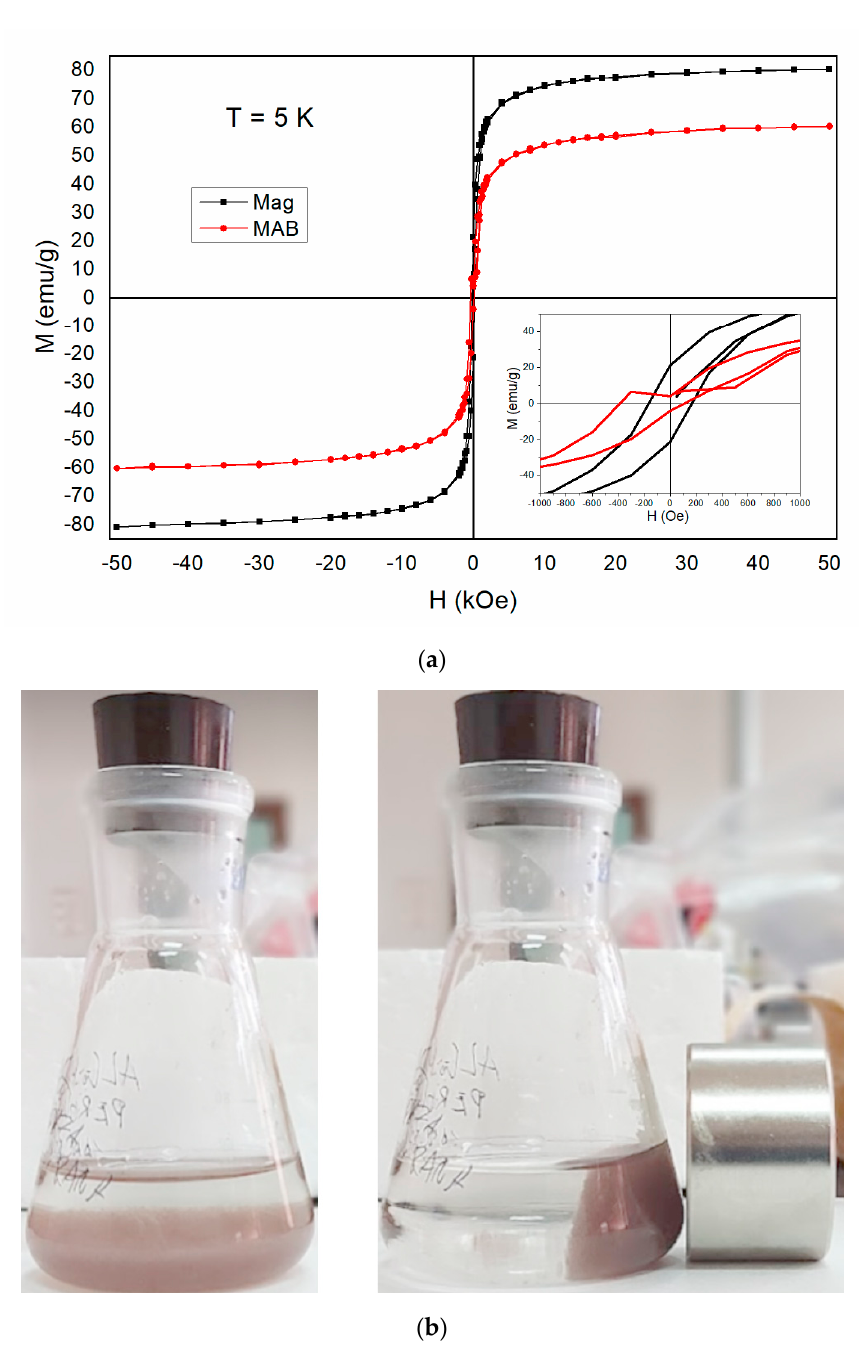
Figure 4. ( a ) Magnetization curves of Mag and MABs ( b ) the separation of MABs by external magnetic field just within 1 min.